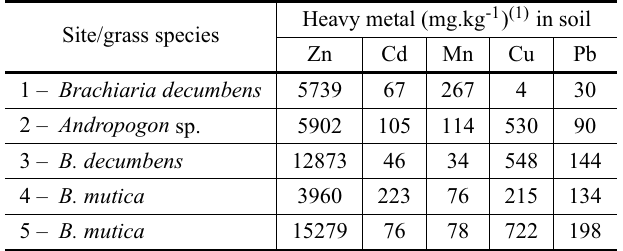
Heavy metal concentrations (Mehlich1) in soil samples from the various sites. Site/grass